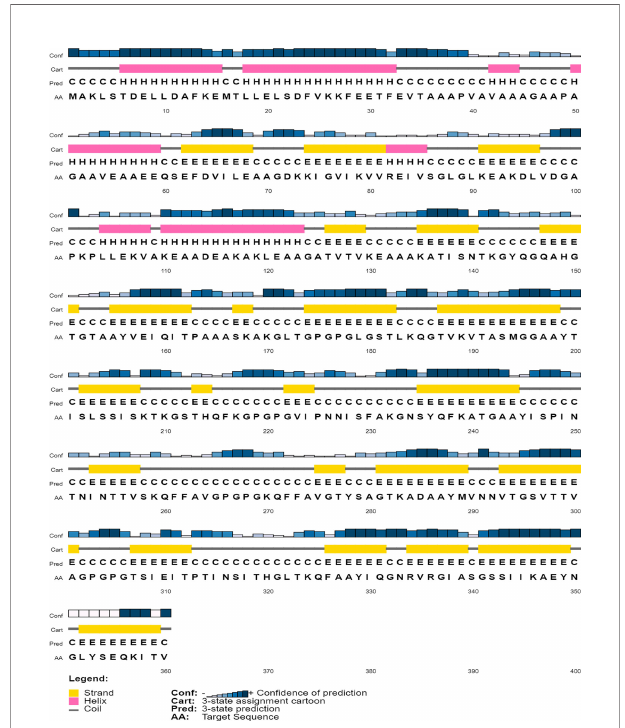
FIGURE 3 | Secondary structure content of the vaccine